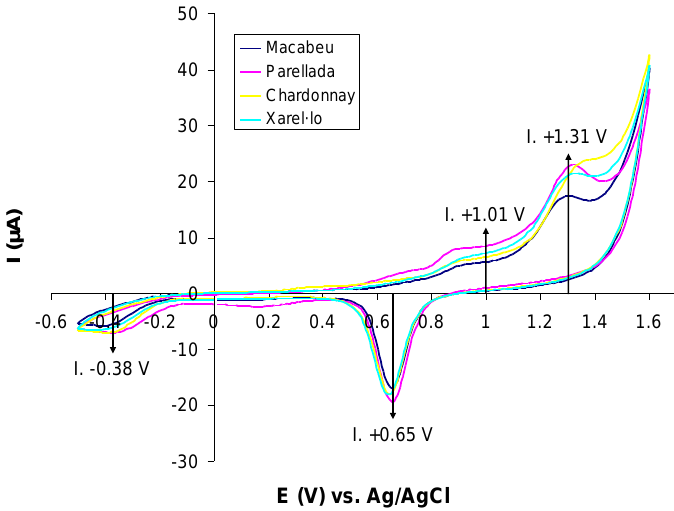
Figure 2. Cyclic voltammograms obtained with the Au microelectrode for four Catalan wines, one of each grape variety. Intensities for the indicated peaks were used as variables for the model.